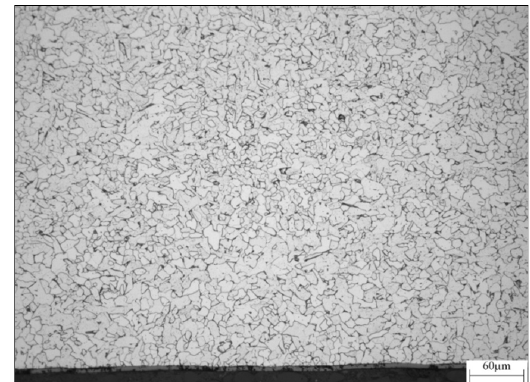
Figure 1: Steel sheet substrate before any heat treatment.